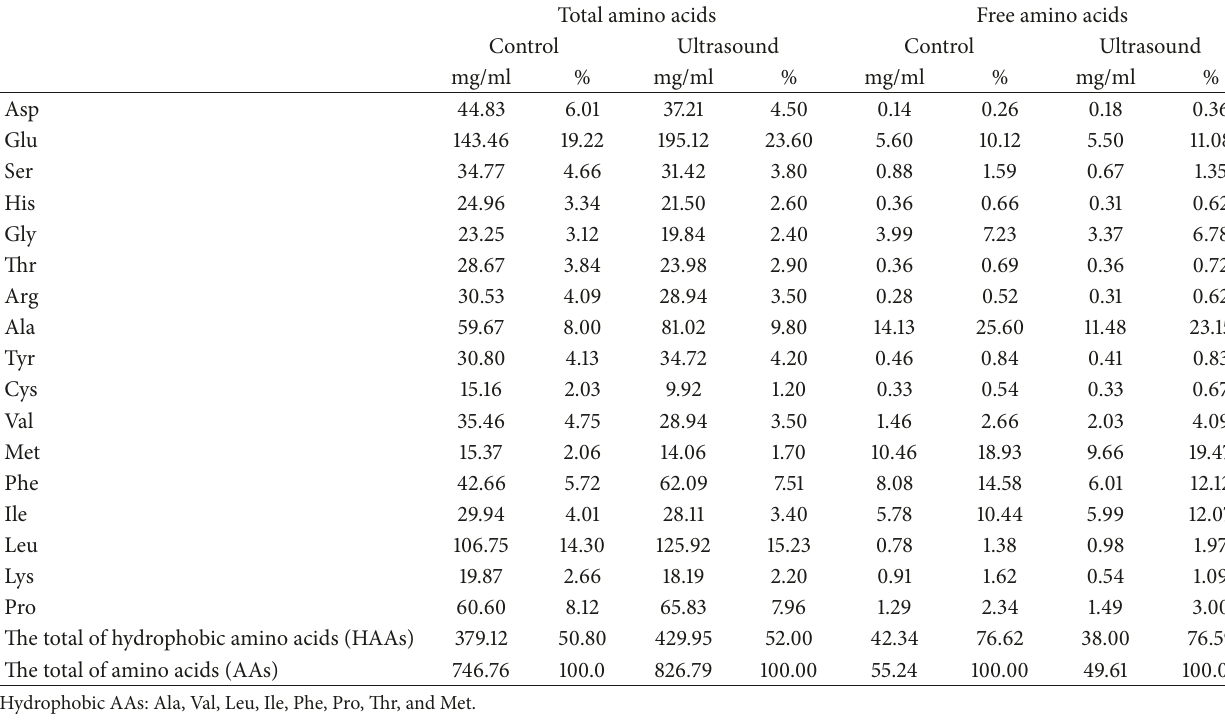
Table 4: Total and free amino acids composition of corn protein hydrolysates.